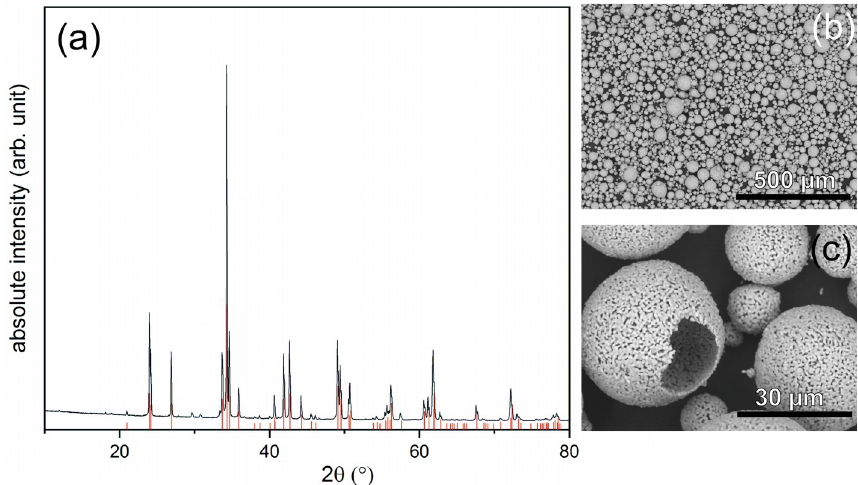
Figure 2. XRD measurement ( a ) and SEM images ( b , c ) of the used YAlO 3 powder. The diffraction pattern of YAlO 3 is shown in red.